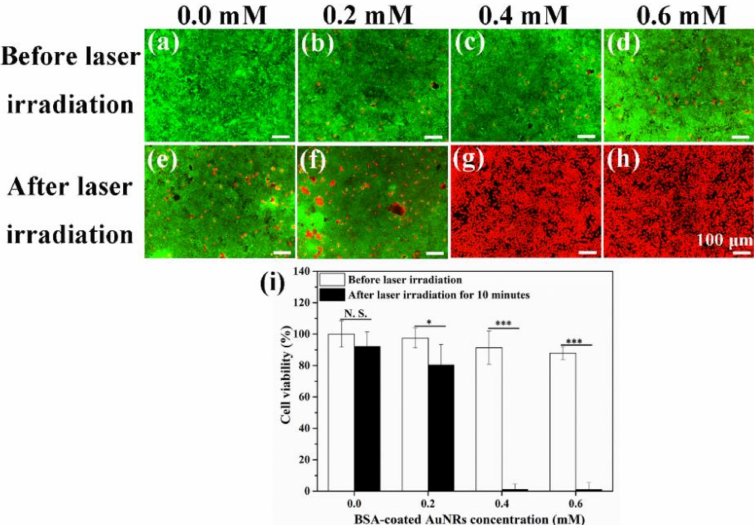
Figure 6. Live/dead staining ( a – h ) and viability ( i ) of 4T1-Luc cells before and after NIR laser irradiation for 10 min after the cells were cultured in medium containing BSA-coated AuNRs at different Au concentrations of 0.0, 0.2, 0.4 and 0.6 mM for 6 h. Green color indicates live cells while red color indicates dead cells. Data are presented as mean ± standard deviation, n = 3. No significant difference: N.S.; significant difference: * p < 0.05; *** p <